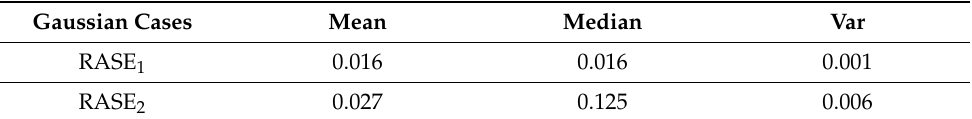
Table 14. The RASE criterion with the non-parametric function η ( . ) and slope function β ( . ) for the case n = 1000.